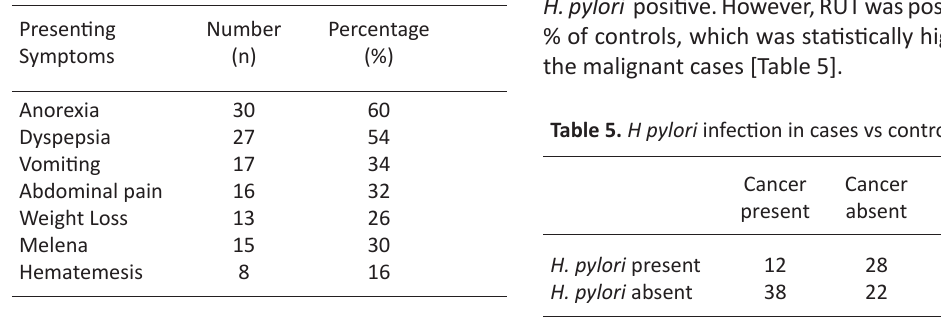
Table 2. Clinical Presentation of Gastric Carcinoma